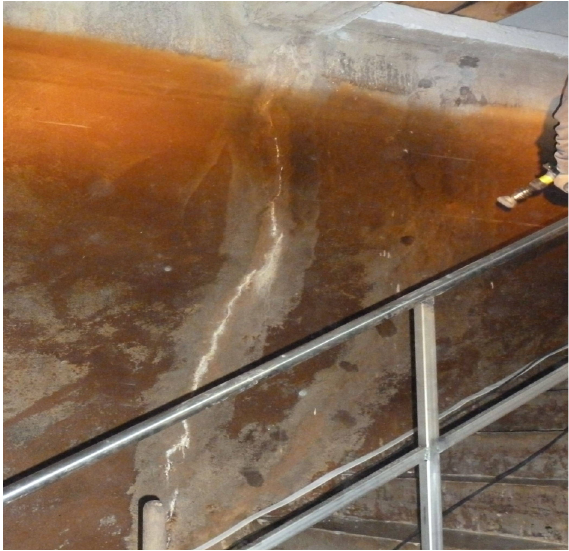
Figure 6: The exemplifying crack with salting out in the longitudinal partition